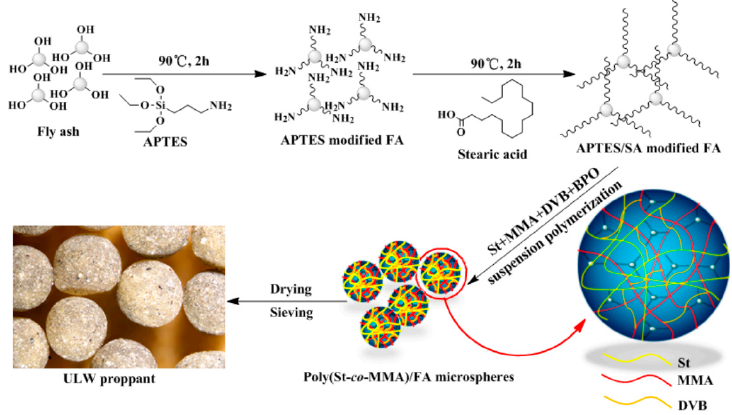
Figure 10. Chemical structure of PMMA and PS.